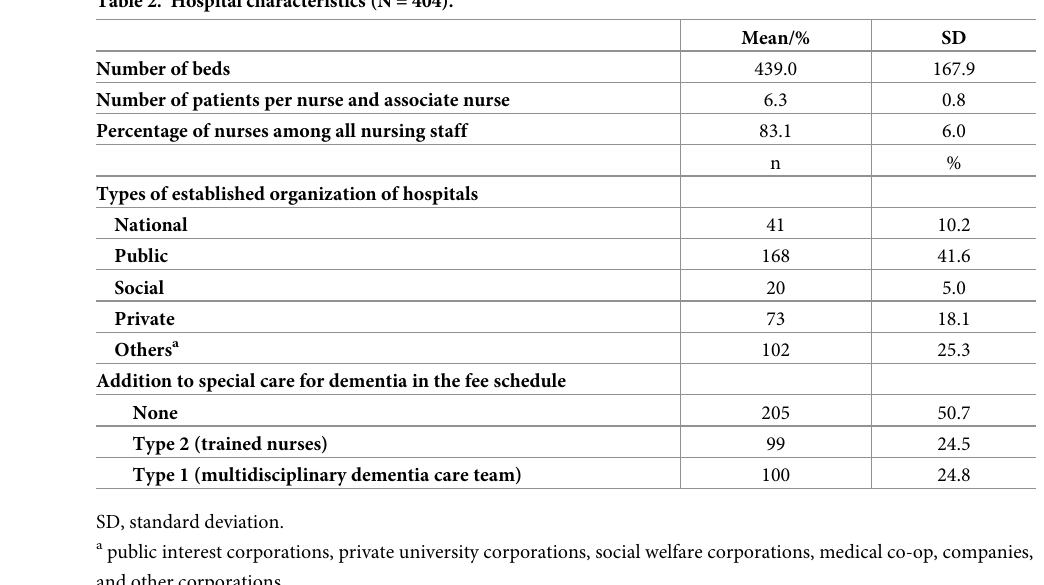
Table 2. Hospital characteristics (N =